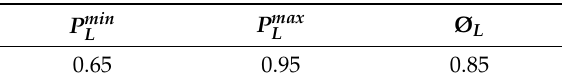
Figure 8. Flowchart of CG power dispatch.